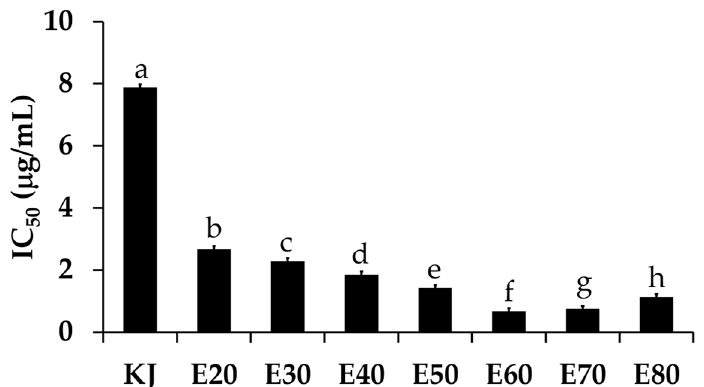
Figure 5. The IC 50 values of the tyrosinase inhibitory activity of kojic acid (KJ) and Sripanya pomegranate peel extracts. E20, E30, E40, E50, E60, E70, and E80 were Sripanya pomegranate peel extracts obtained by maceration in 20%, 30%, 40%, 50%, 60%, 70%, and 80% v/v of ethanol. Different letters denote statistically significant differences among groups; ( p < 0.05).